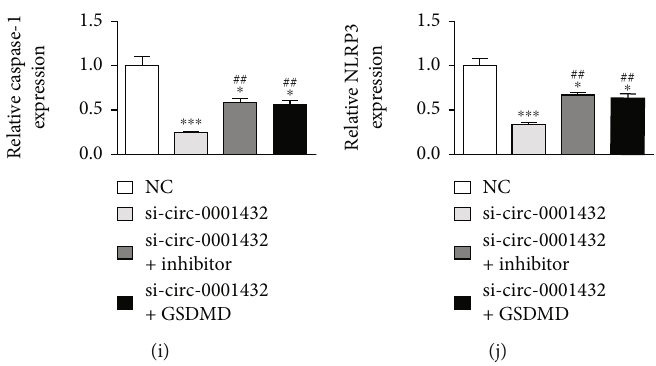
Figure 3: Downregulation circ-Katnal1 suppressed LPS-induced in fl ammatory pyroptosis in RAW264.7 cells. However inhibiting miR-31- 5p or upregulating GSDMD reversed the protective e ff ect after circ-Katnal1 silencing. (a) – (c) RT-qPCR detection showed the expression of circ-Katnal1, miR-31-5p, and GSDMD. (d) – (f) ELISA detection showed the expression of in fl ammatory factors TNF- α , IL-1 β , and IL-6 under LPS condition (1 μ g/mL). Data were presented as mean ± SD . ∗ P < 0 : 05 , ∗∗ P < 0 : 01 , ∗∗∗ P < 0 : 001 , versus sham NC. ## P < 0 : 01 , ### P < 0 : 001 , versus si-circ-Katnal1 (si-mmu_circ_0001432). (g) – (j) Western blot detection showed GSDMD, caspase-1, and NLRP3 expression. Data were presented as mean ± SD . ∗∗∗ P < 0 : 001 , versus the sham group. Data were presented as mean ± SD . ∗ P < 0 : 05 , ∗∗∗ P < 0 : 001 , versus sham NC; # P < 0 : 05 , ## P < 0 : 01 , ### P < 0 : 001 , versus si-circ-Katnal1